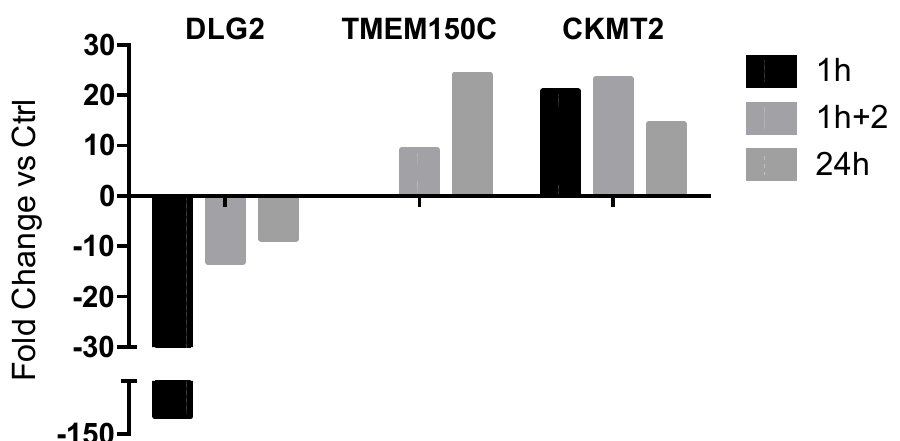
Figure 2. Time ‐ trends of the three genes differentially expressed recurring at any time of analysis in Figure 2. Time-trends of the three genes di ff erentially expressed recurring at any time of analysis in U937 cells. U937